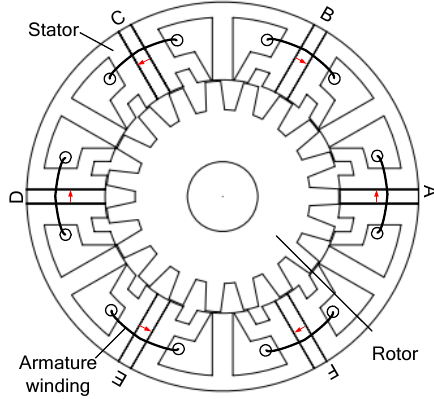
Figure 2. Fault-tolerant FSPM (MTFTFSPM) machine.